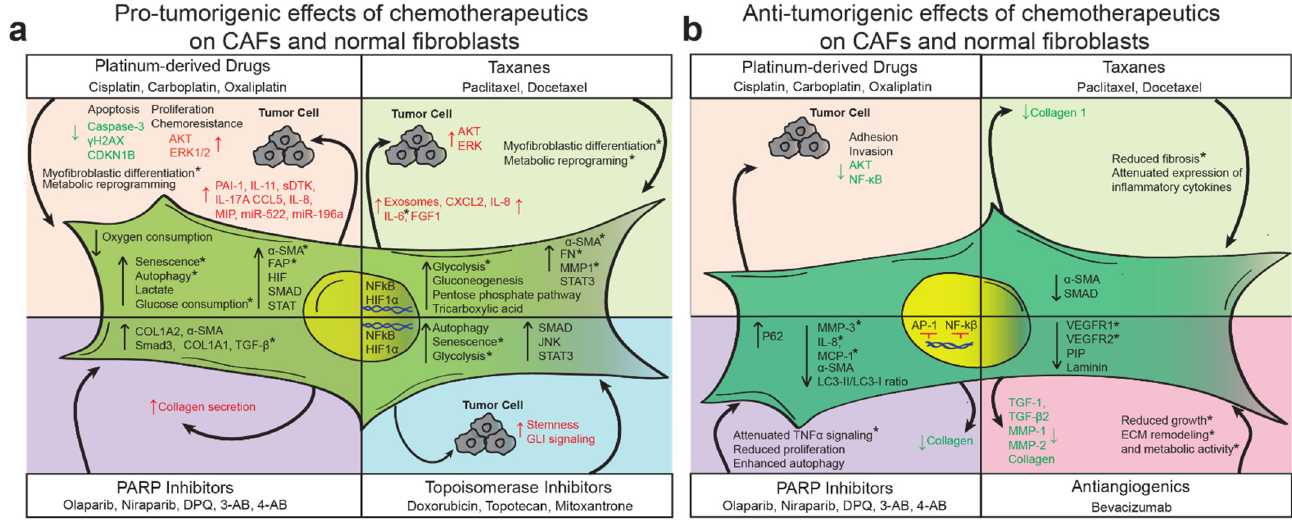
Figure 2. Effects of therapeutic agents on cancer associated fibroblasts (CAF)s. The diverse therapeutics used in the treatment of ovarian cancer, including platinum agents, taxanes, Poly ADP-ribose polymerases (PARP) inhibitors, tomoisomerase inhibitors, and anti-angiogenics, may have ( a ) pro-tumorigenic or ( b ) anti-tumorigenic effects on CAFs. * Experimental or clinical observations in normal fibroblasts or fibroblasts from disease states other than cancer.